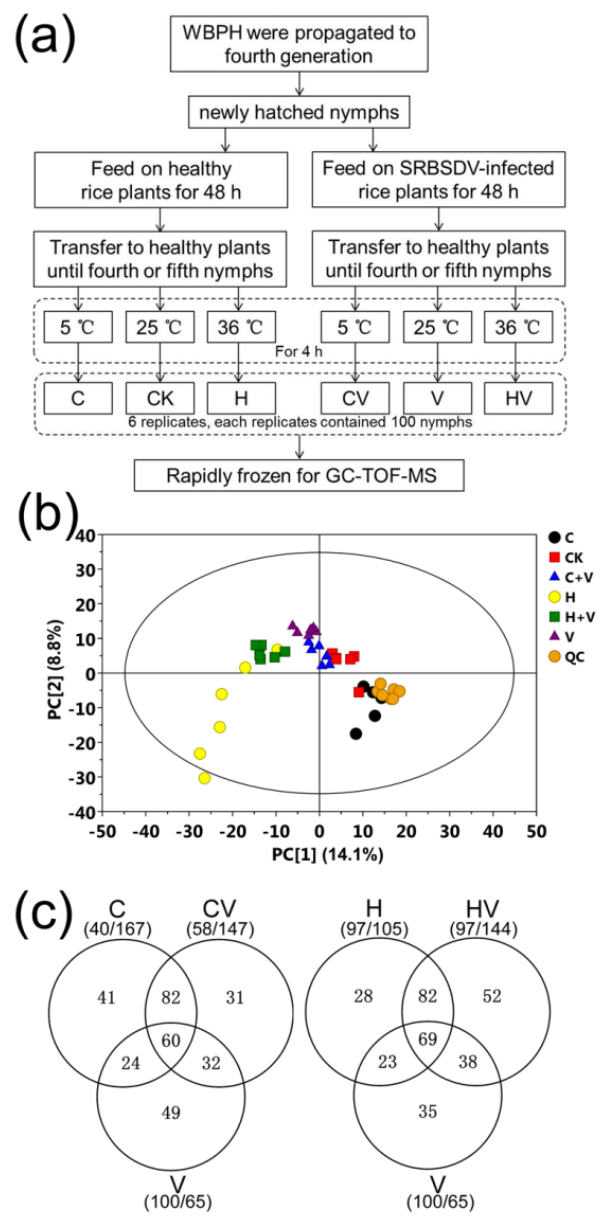
Figure 1. Overview of this metabolomic study. ( a ) Experimental design and work flow of this study. ( b ) Scores plot of the principle components analysis (PCA) model of the gas chromatography-time of flight-mass spectrometry (GC-TOF-MS) data of all samples. ( c ) Venn diagram of the numbers of differentially accumulated metabolites induced by virus infection under cold stress (left) and heat stress (right). Note: CK, the unstressed white-backed planthopper (WBPH) sample; C, cold-stressed WBPH sample; H, heat-stressed WBPH sample; V, Southern rice black-streaked dwarf virus (SRBSDV)-carrying WBPH sample; CV, cold-stressed SRBSDV-carrying WBPH sample; HV, heat-stressed SRBSDV-carrying WBPH sample; and QC, quality control sample.